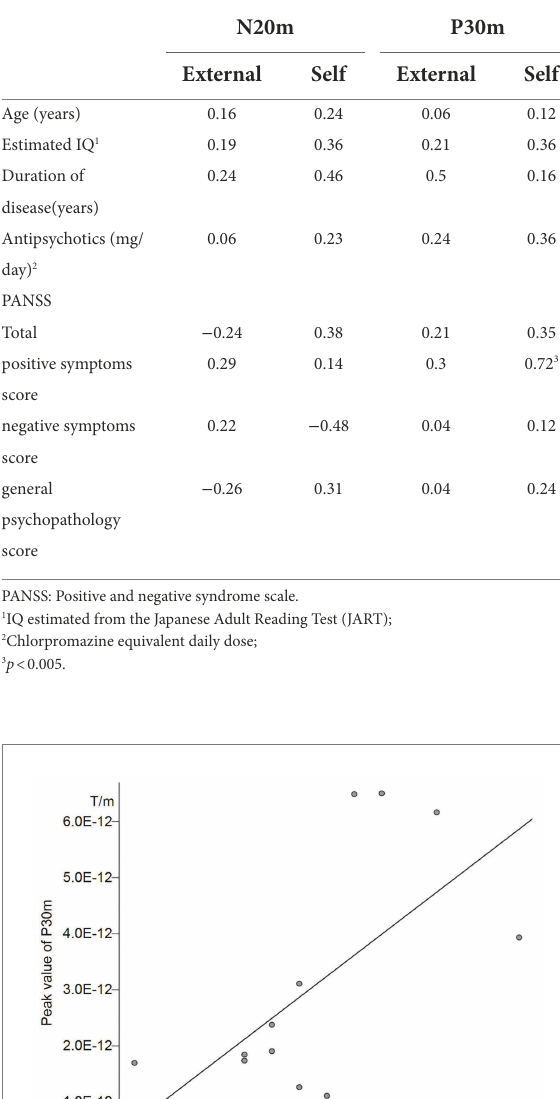
TABLE 3 Spearman’s correlation coefficient for SEF (N20m, P30m) amplitude and demographic factors.